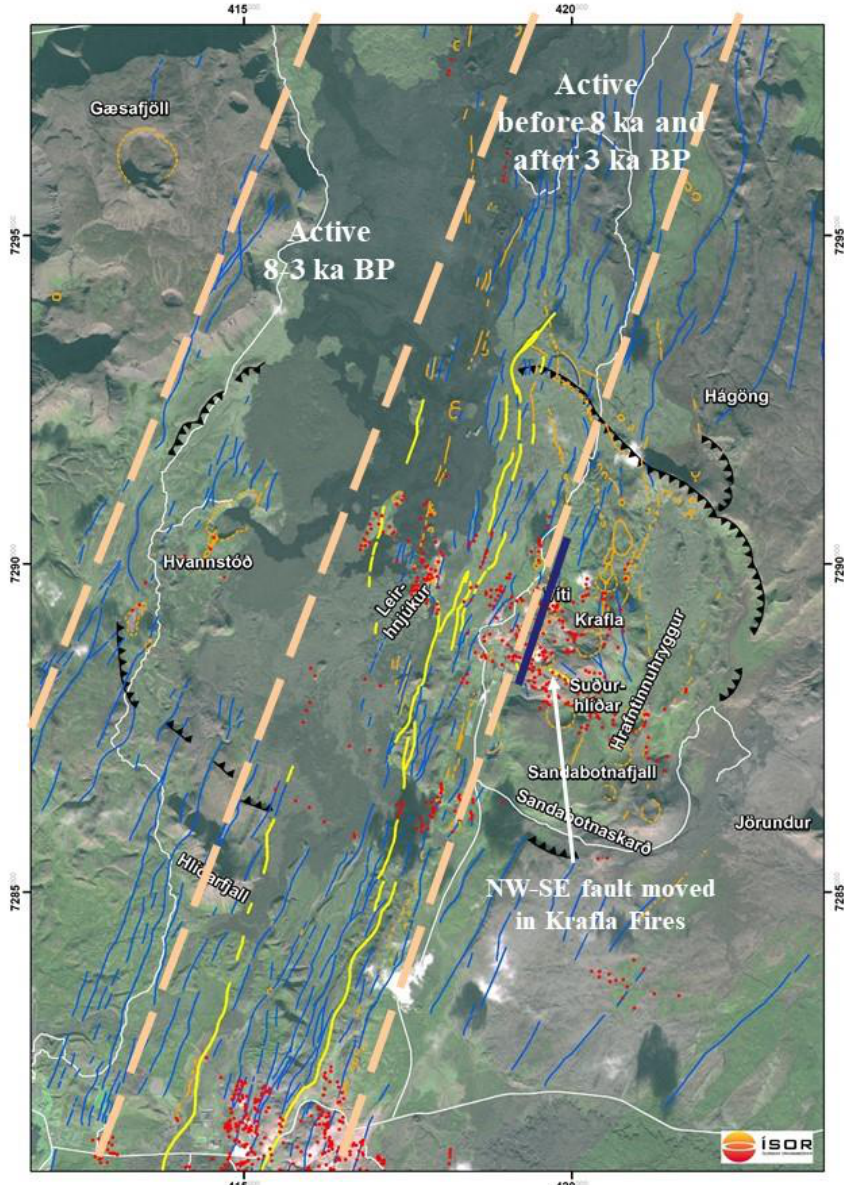
Figure 4. Di ff erent parts of the fissure swarm active at di ff erent times. Blue lines are faults and fissures, yellow lines show the eastern- and westernmost faults and fissures activated in the Krafla Fires and NW–SE fault south of Mnt. Krafla that moved in the Krafla Fires. The purple line marks the Hveragil gulley. Orange lines mark eruptive craters and fissures. Coordinates are UTM, WGS84, zone 28 in km.